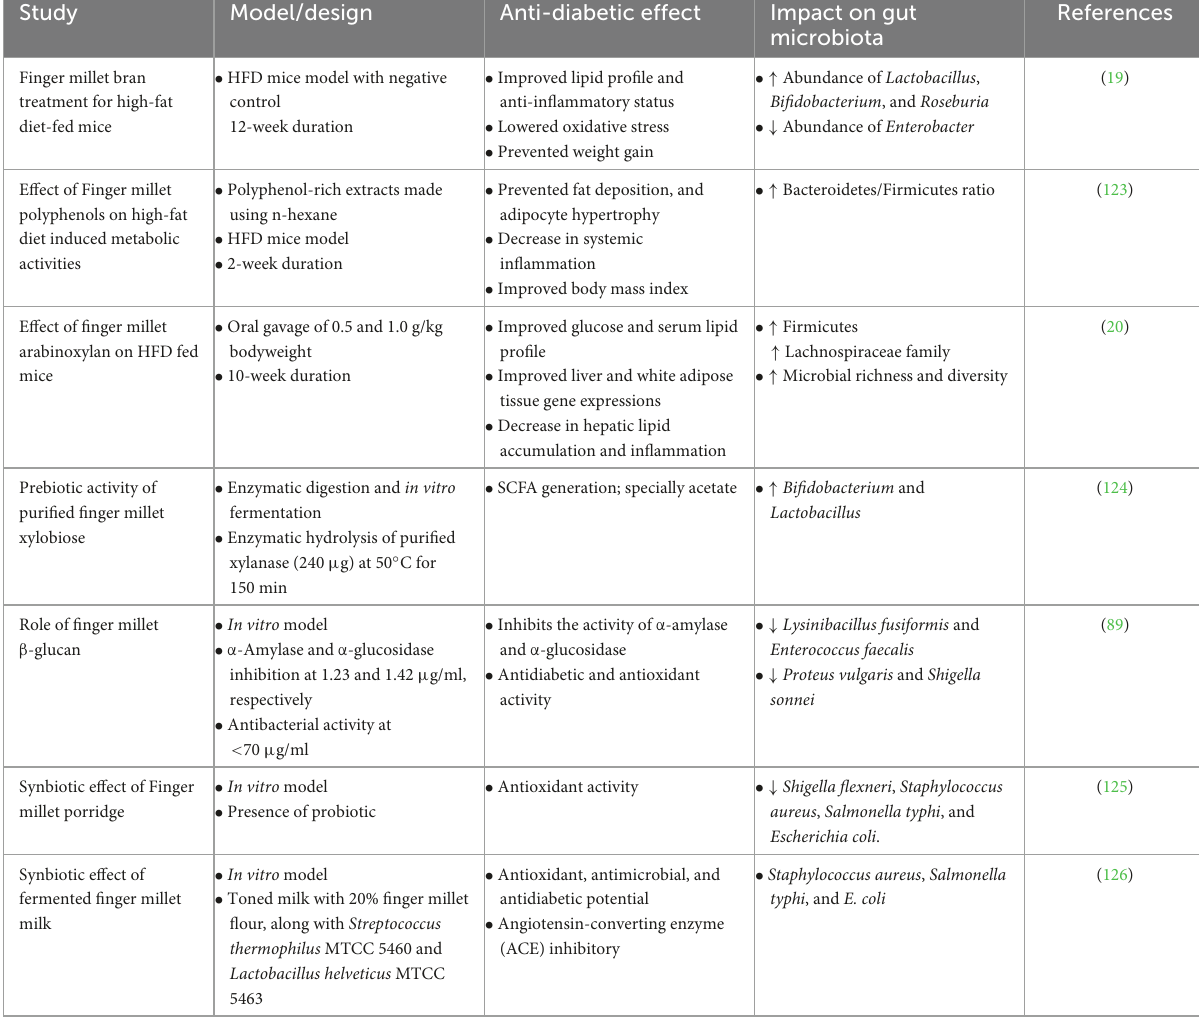
TABLE 3 Studies showing anti-diabetic significance of finger millet along with its effect on gut microbiota. Study